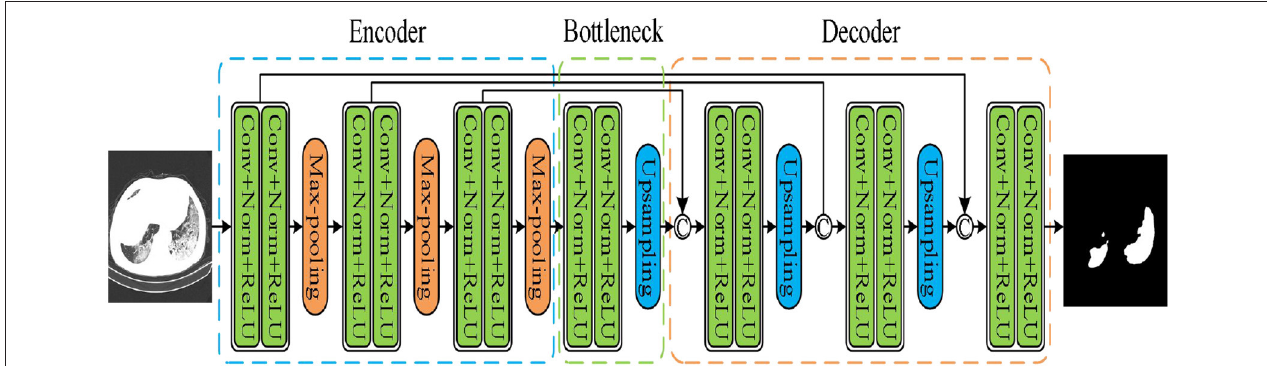
FIGURE 4 | UNet model.